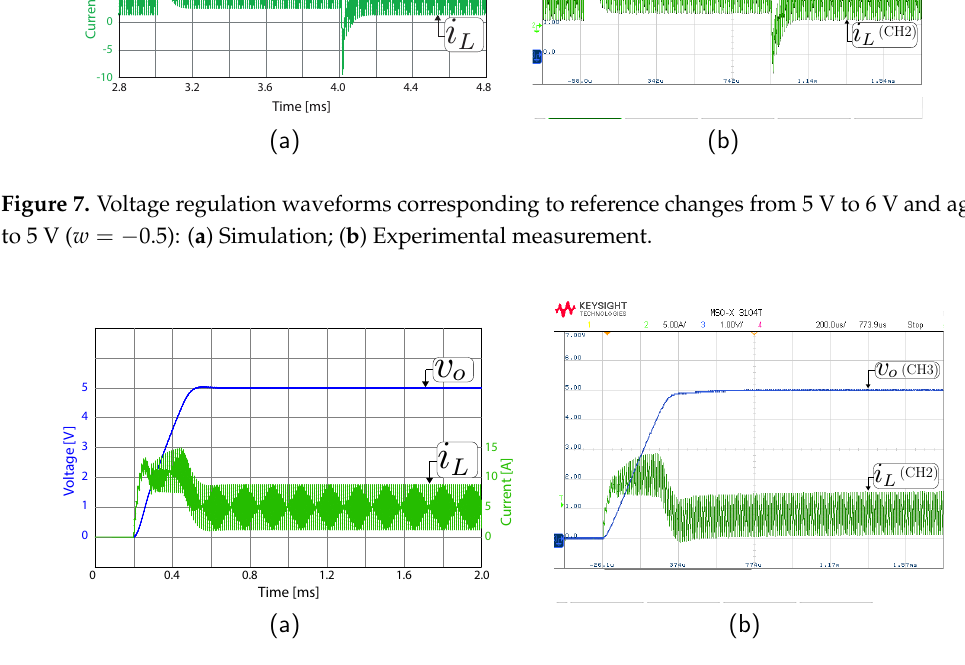
Figure 8. System start-up from zero initial conditions. ( a ) PSIM simulation; ( b ) Experimental